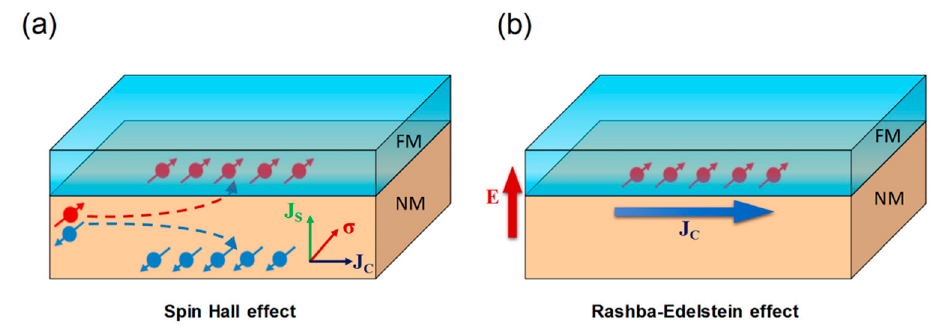
Figure 8. Schematic illustration of the bulk spin Hall effect in a heavy metal ( a ) and the interfacial Rashb—Edelstein effect ( b ). Reprinted with permission from ref. [64] 2018 APS.